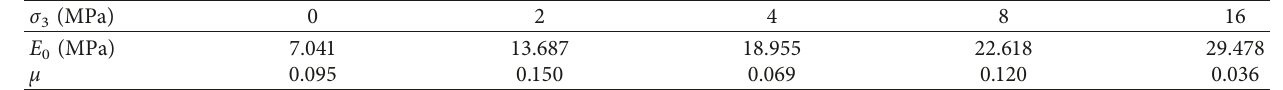
Figure 8: The energy evolution laws of b2 rocks under loading conditions: (a) 2MPa; (b) 4MPa; (c) 8MPa; (d) 16MPa. Table 5: The deformation parameters under different confining pressures.